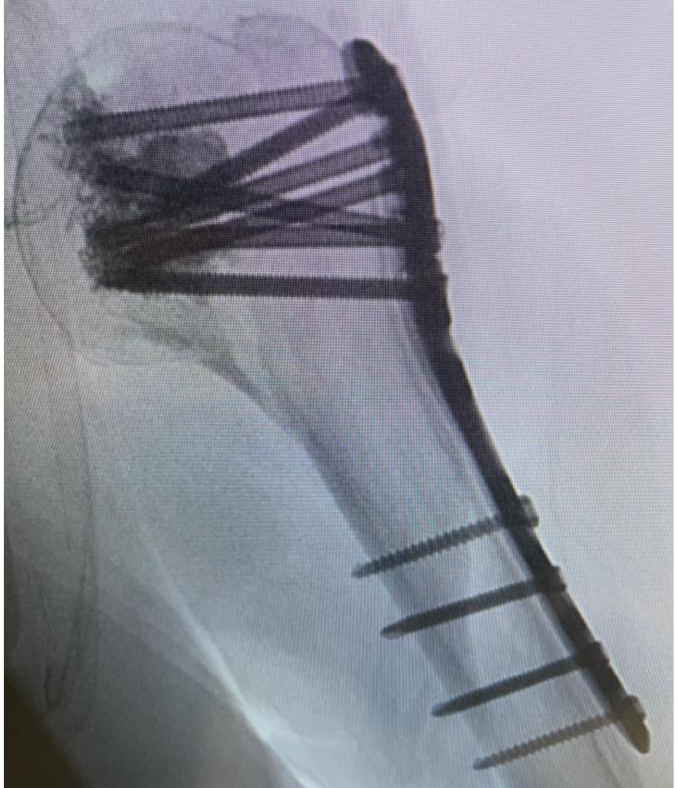
Figure 3. Fluoroscopic control after cement augmentation of the screws. The arm was immobilized for 10 days after surgery. Physiotherapy with passive forward flexion and abduction up to 90 ◦ started on day 11. Lifting and free motion was allowed starting week 7 after